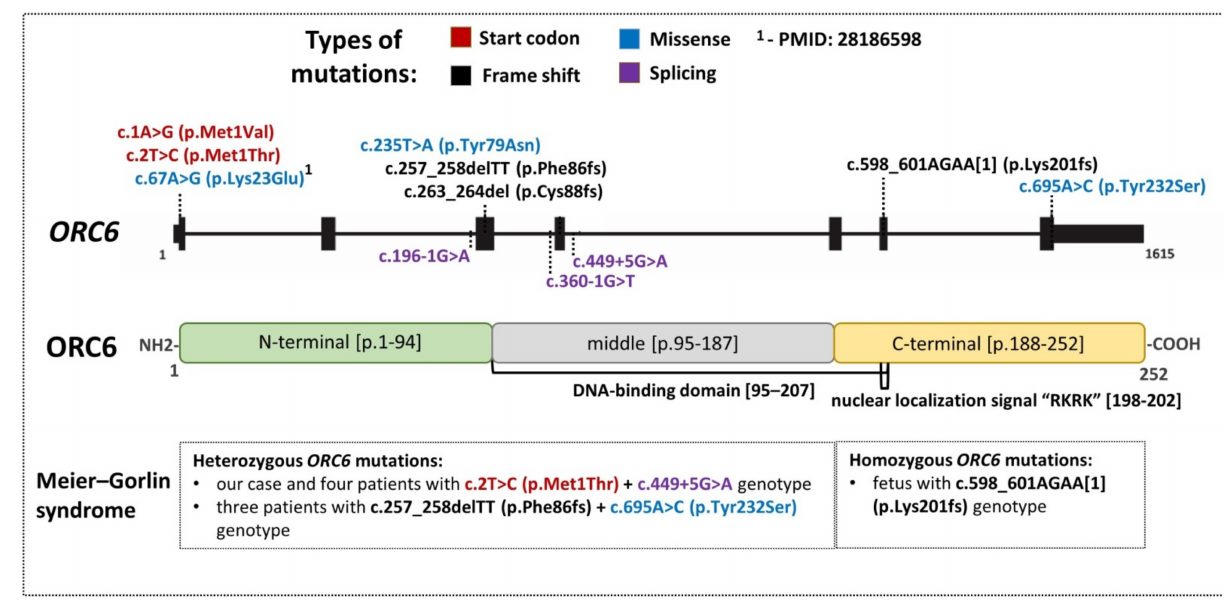
Figure 4. The ORC6 gene and protein and phenotypes of mutations [2,4,5]. Bicknell et al. (2011) found three affected children from one family with compound heterozygous mutations in the ORC6 gene: one loss-of-function mutation caused by a 2 bp deletion designated as c.257_258delTT (p.Phe86fs) and missense mutation c.695A>C inducing a substitution of an amino acid (p.Tyr232Ser) [4]. All three patients manifested growth retardation, microtia and other ear malformations, aplastic or hypoplastic patella, full lips and micrognathia; two males had cryptorchidism, and a female had mammary hypoplasia (Figure